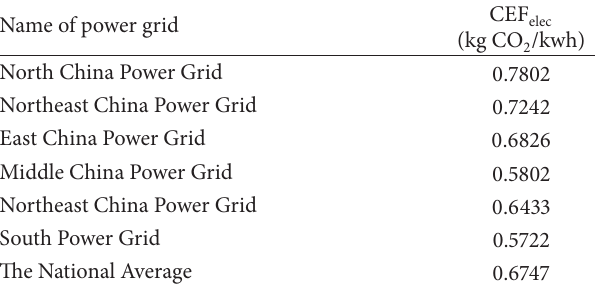
Table 1: Electricity carbon emission